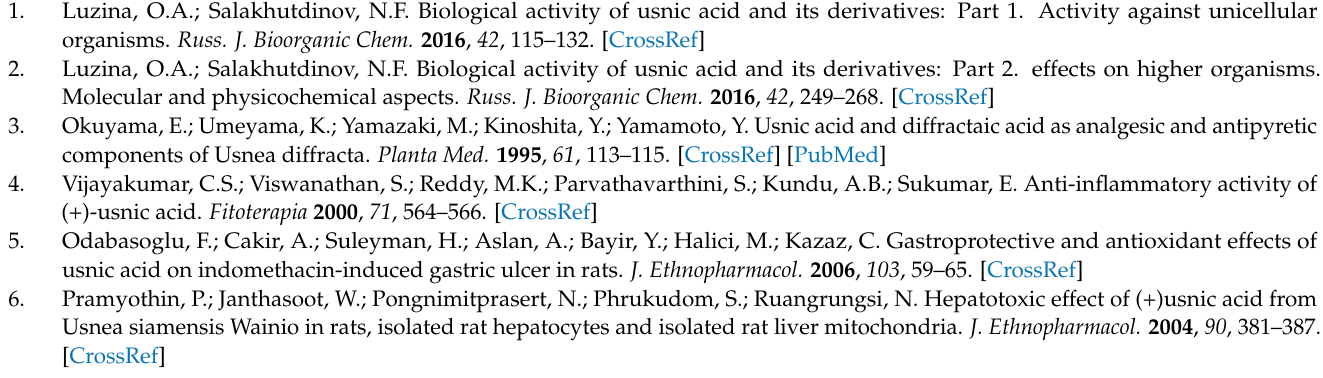
compound 2 ; Figure S2: The 1 H NMR spectrum of compound 3 ; Figure S3: The 1 H NMR spectrum of compound 4 ; Figure S4: The 1 H NMR spectrum of compound 5 ; Figure S5: The 1 H NMR spectrum of compound 6 ; Figure S6: The 13 C NMR spectrum of 6; Figure S7: The DFS spectrum of 6; Figure S8: The 1 H NMR spectrum of compound 7 ; Figure S9: The 13 C NMR spectrum of 7; Figure S10: The DFS spectrum of 7; Figure S11: The 1 H NMR spectrum of compound 7; Figure S12: The 13 C NMR spectrum of 7; Figure S13: The IR spectrum of 7; Figure S14: The DFS spectrum of